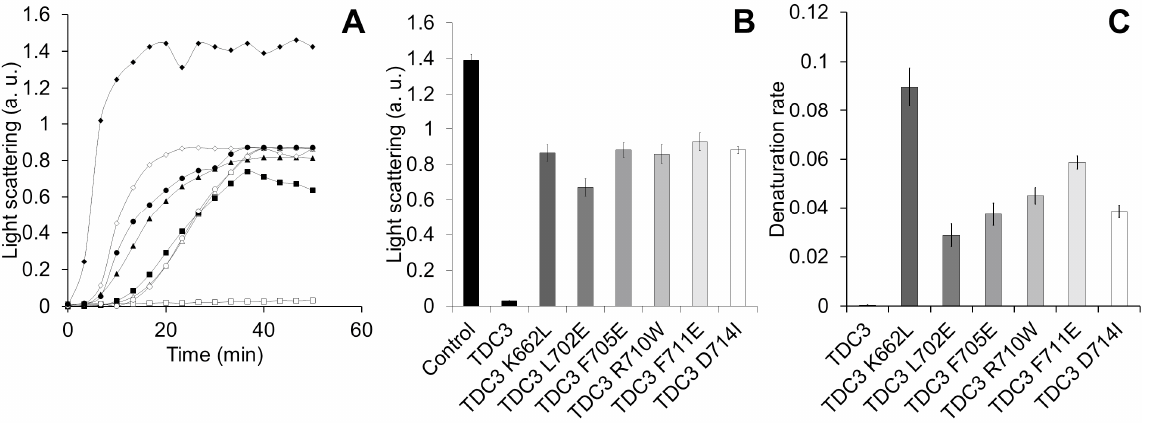
Figure 6. Mutation of specific amino acid residues of the C-terminal loop diminishes chaperone activity. ( A ) Representative traces for ADH (6 µM) heat denaturation at 55 °C for 50 min, determined by light scattering at 360 nm, in the presence of TDC3 (6 µ M) having a substitution of a specific amino acid residue: TDC3 (control) (open squares), TDC3 K662L (open diamonds), TDC3 L702E (closed squares), TDC3 F705E (open circles), TDC3 R710W (closed triangles), TDC3 F711E (closed circles), and TDC3 D714I (open triangles). ( B ) Average of the final light-scattering value from three independent experiments. ( C ) ADH heat denaturation rate in the presence of the substitution variants, average of three independent experiments.